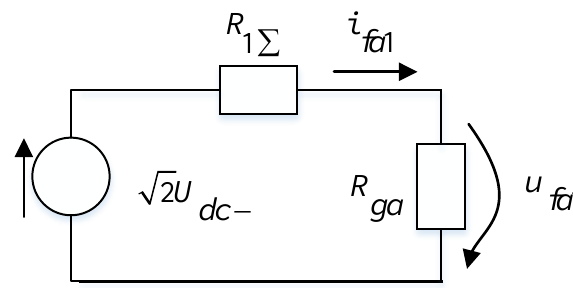
Figure 12. Sequence network connections for pole-pole to ground fault.